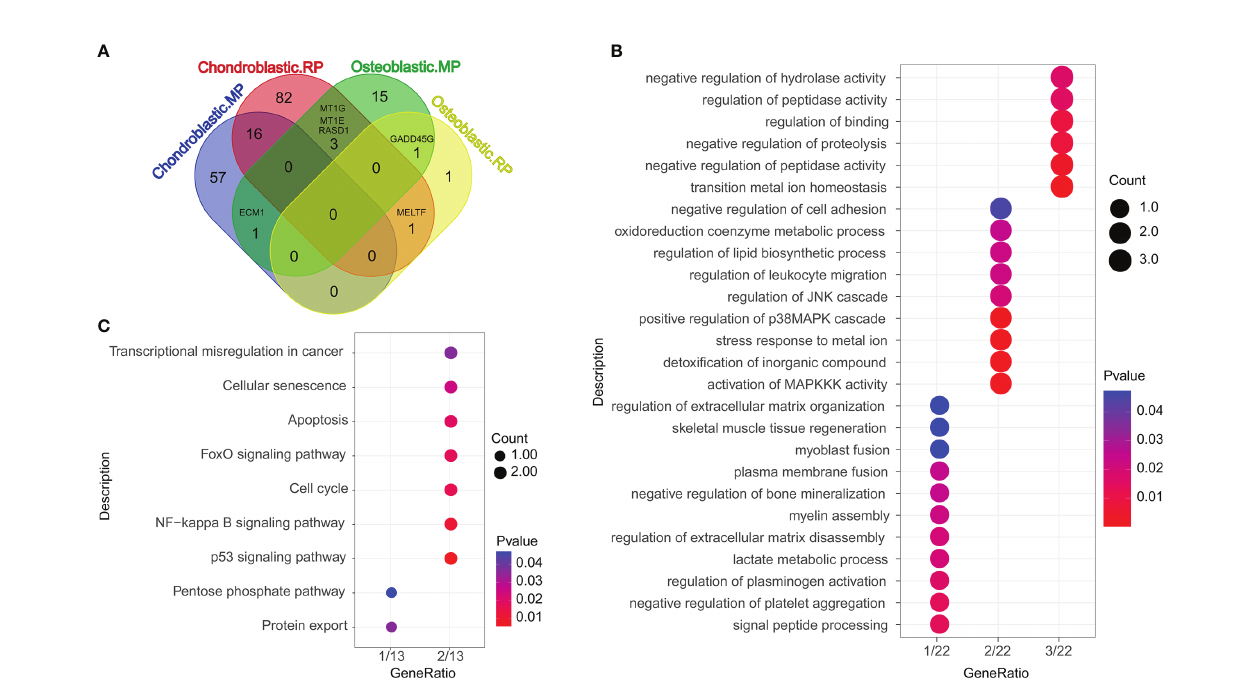
FIGURE 2 | Functional enrichment analysis of differentially expressed genes (DEGs). (A) The Venn diagram showed the overlapped DEGs according to different cell types. Chondroblastic. MP = the DEGs in chondroblastic cells from metastatic osteosarcoma as compared with those from primary osteosarcoma. Chondroblastic. RP = the DEGs in chondroblastic cells from recurrent osteosarcoma as compared with those from primary osteosarcoma. Osteoblastic. MP = the DEGs in osteoblastic cells from metastatic osteosarcoma as compared with those from primary osteosarcoma. Osteoblastic. RP = the DEGs in osteoblastic cells from recurrent osteosarcoma as compared with those from primary osteosarcoma. (B) The GO enrichment analysis of overlapped DEGs between each of two groups. (C) The KEGG pathway enrichment analysis of overlapped DEGs between each of two